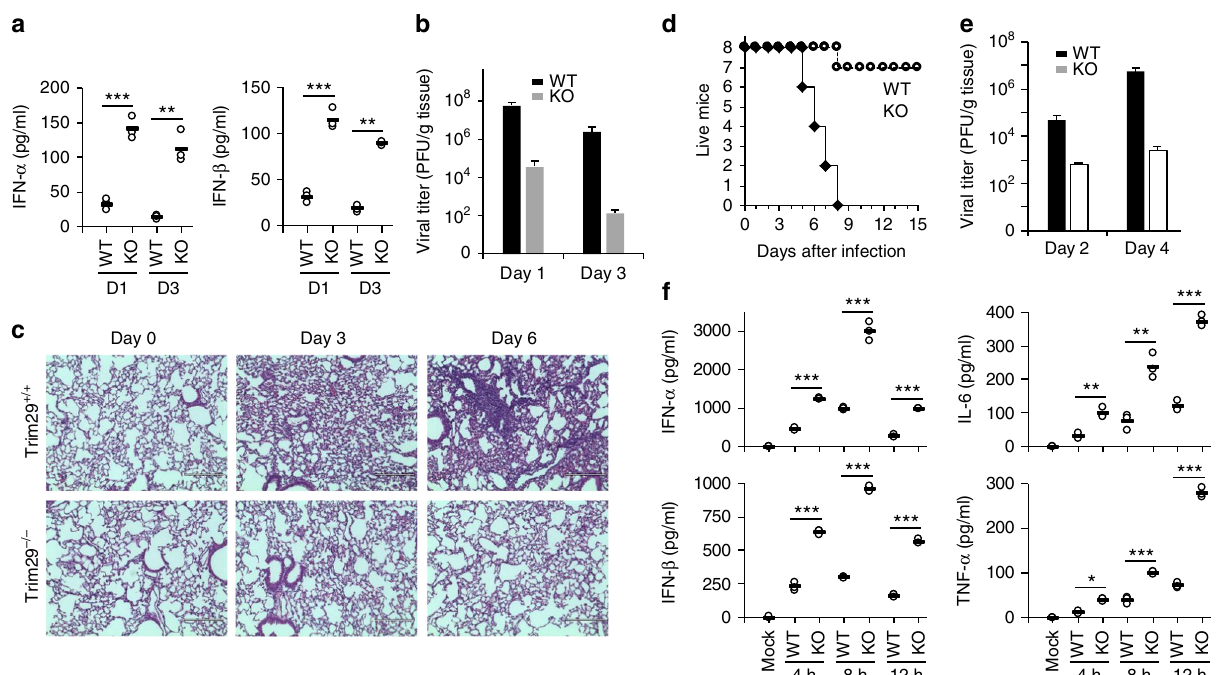
Fig. 4 TRIM29 plays an important role in host defense against viral infection in vivo. a ELISA of IFN- α and IFN- β in BALF samples from WT and Trim29-KO mice ( n = 3 per strain) on day 1 or day 3 of intranasal infection with adenovirus (1 × 10 8 PFU per mouse). b Viral titers in homogenates of lung from WT and Trim29-KO mice ( n = 3 per strain) on day 1 or day 3 of intranasal infection with adenovirus (1 × 10 8 PFU per mouse). c Hematoxylin and eosin (H&E) staining of lung sections from Trim29 +/+ and Trim29 − / − mice intranasally infected with adenovirus (1 × 10 8 PFU per mouse) on day 0, day 3, or day 6. Scale bars represent 400 µ m. d Survival of WT and Trim29 -KO mice ( n = 8 per strain) after intravenous injection of HSV-1 (2 × 10 7 PFU per mouse). e Viral titers in homogenates of brains from WT and Trim29 -KO mice ( n = 3 per strain) after intravenous injection of HSV-1 (2 × 10 7 PFU per mouse). f ELISA of IFN- α , IFN- β , TNF- α , and IL-6 in the serum obtained from WT and Trim29 -KO mice ( n = 3 per strain) at various times ( horizontal axes ) after intravenous injection of HSV-1 (2 × 10 7 PFU per mouse). Each symbol represents the value from independent experimental cells in each well; small horizontal lines indicate the average of triplicates. * P < 0.05, ** P < 0.01, and *** P < 0.001 (unpaired t -test). Data are representative of three experiments (mean and SD of three samples in b , e